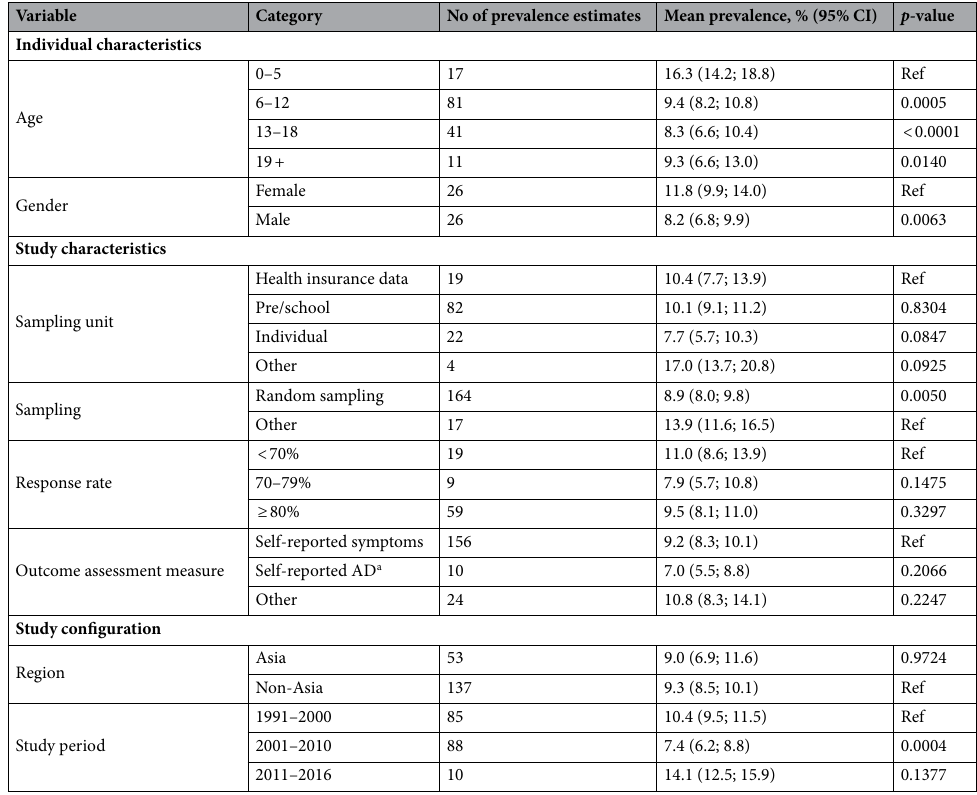
Table 2. Subgroup analyses of factors associated with 12-month AD prevalence. a Diagnosed by a health care